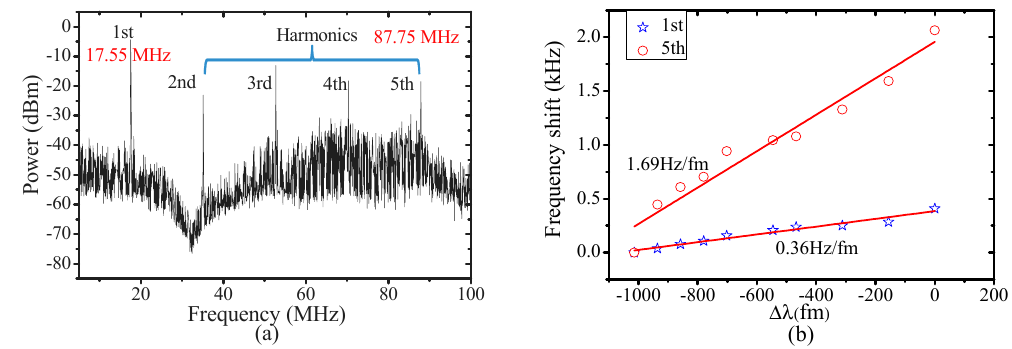
Figure 7. ( a ) Mechanical spectra of a hollow MBR above threshold power; ( b ) OSE of the 5th harmonic (hollow red circle) and the fundamental (hollow blue five-pointed star) modes.